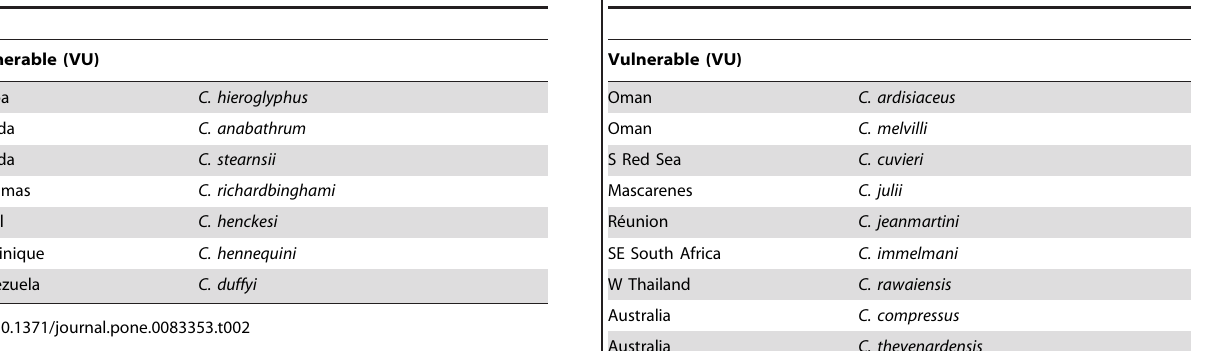
Table 2. Threatened Conus of the Western Atlantic (WA). Table 3. Threatened Conus of the Indo-Pacific